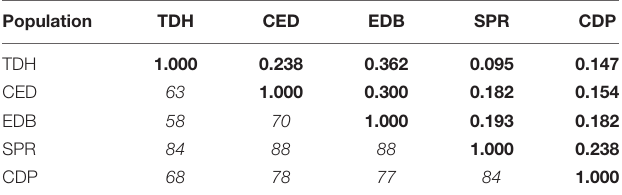
TABLE 4 | Jaccard index of similarity (bold) and number of fungal species identified in roots of each pair of populations (italic) of Festuca rubra subsp. pruinosa plants from marine